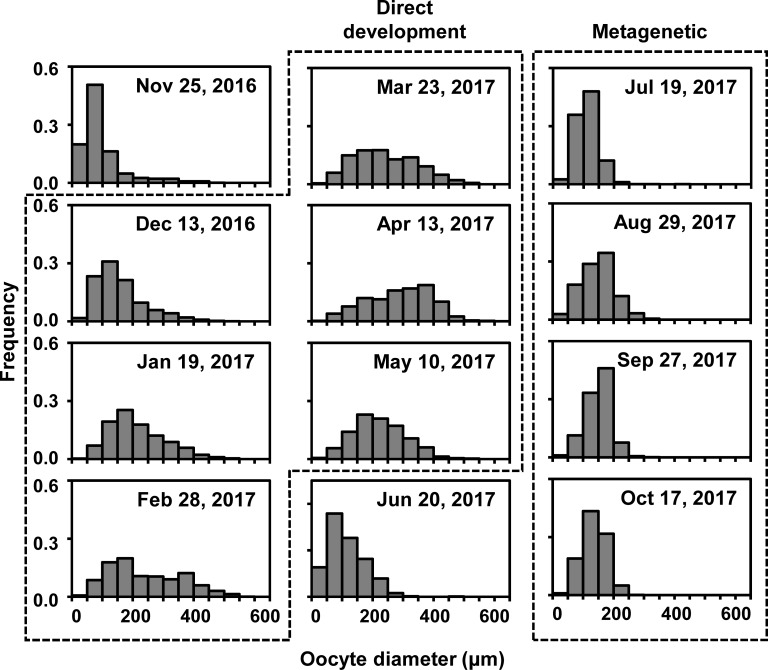
Seasonal change in oocyte diameter.Two boxes with dashed lines indicate the direct-development and metagenetic periods.